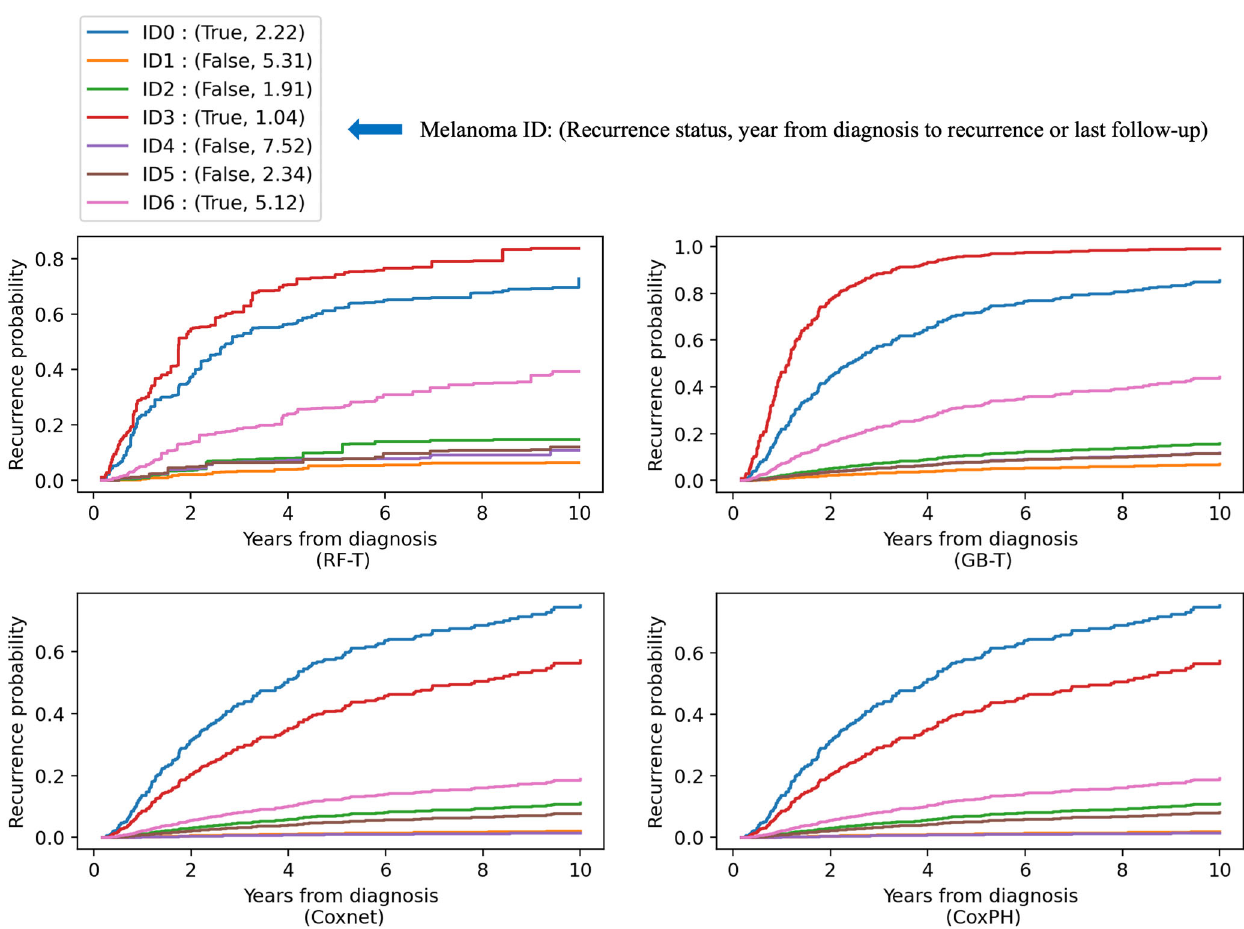
Fig. 6 Recurrence probabilities for seven randomly selected melanomas in the external cohort (DFCI) predicted by the four time-to-event models trained by the MGB cohort. ID3 (red), ID0 (blue), and ID6 (pink) recurred with an increased duration from diagnosis of the primary melanoma to recurrence. The RF-T and GB-T models predicted them to have the highest recurrence probability proportional to their duration from diagnosis to recurrence. In the comparison of ID0 (recurrence) and ID5 (non-recurrence) where they had similar duration from diagnosis to recurrence or to last follow-up (ID0: 2.22, ID5: 2.34), all four models predicted ID0 to have a higher recurrence